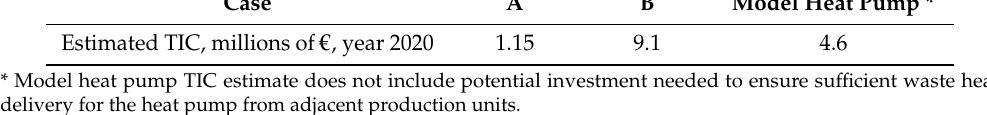
Table 10. Total investment cost (TIC) estimation for Case A, Case B, and model heat pump.